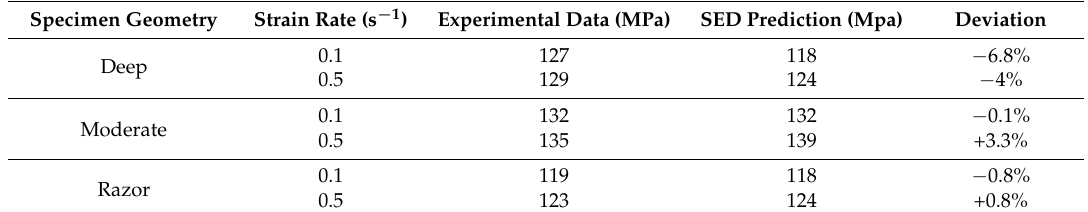
Table 3. Prediction of tensile failure of moderate, deep and razor specimens using the SED approach.